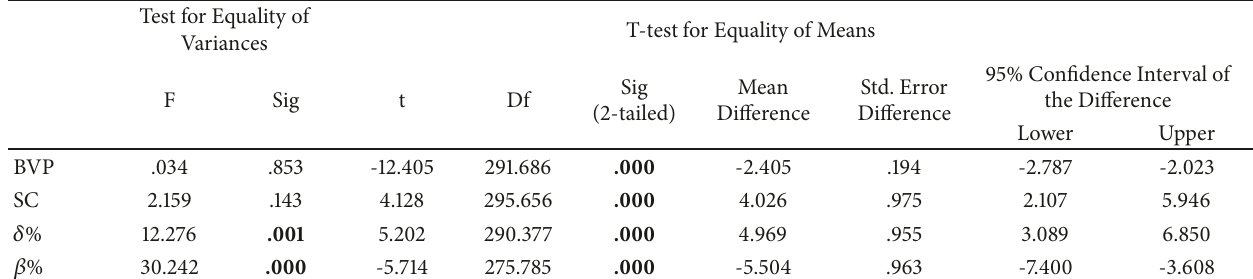
Table 4: T-test for the bio-signals and brain signals in angry driving and normal driving. Test for Equality of